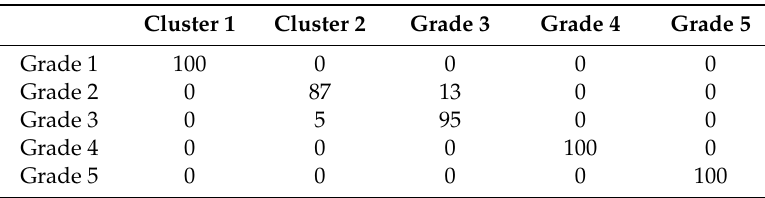
Table 14. System performance for perimeter feature.